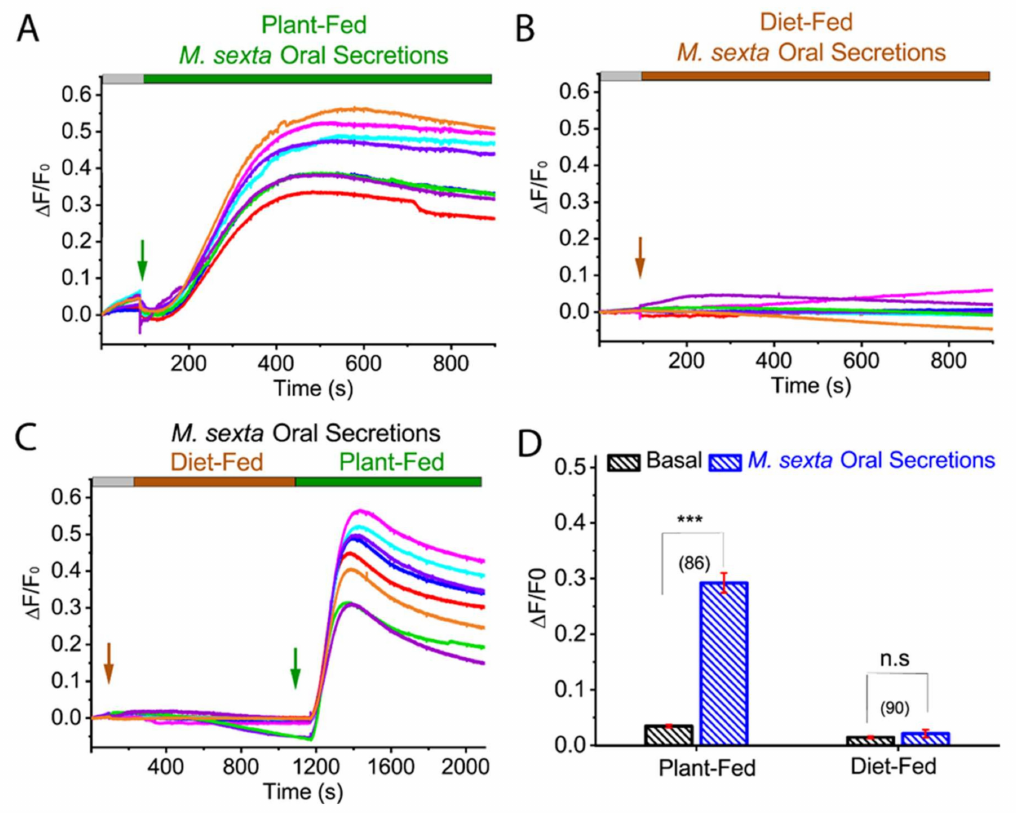
Figure 2. Plant-fed M. sexta OS-induced ROS elevation in tomato protoplasts. Representative ROS imaging of tomato protoplasts with the application of tomato plant-fed (PF) M. sexta OS ( A ), diet-fed (DF) M. sexta OS ( B ), and combination of both ( C ). ( D ) Bar graph analysis of data shown in ( A , B ) depicting maximum ROS generation after PF and DF M. sexta OS application. Statistical indicators